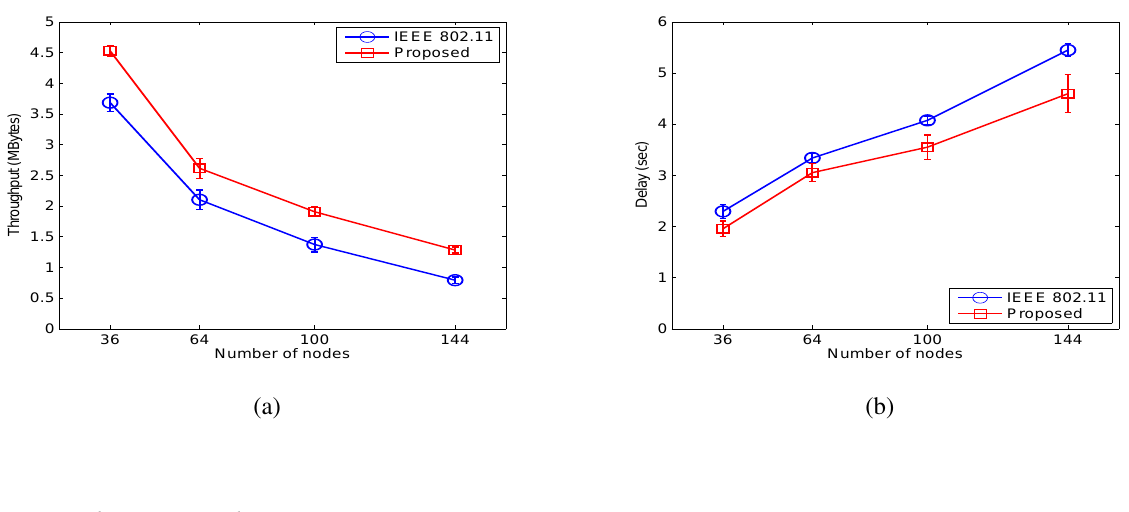
Figure 10. Simulation results for grid networks when σ (b)